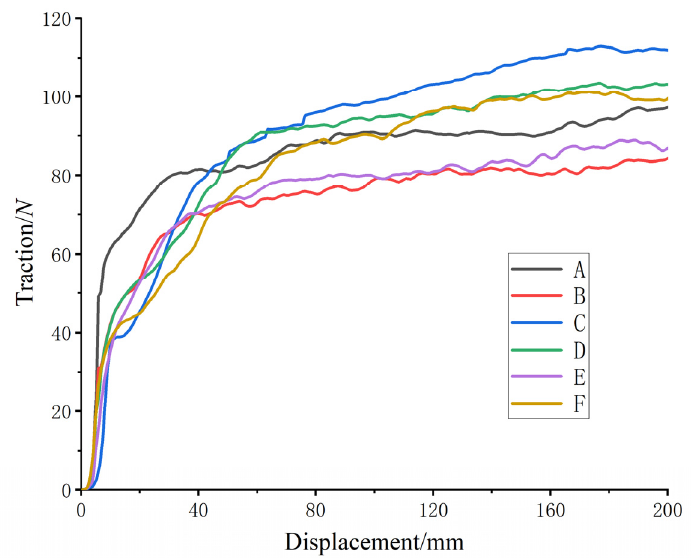
Figure 10. Tire tread-to-soil adhesion output-curve for each tire-groove test.